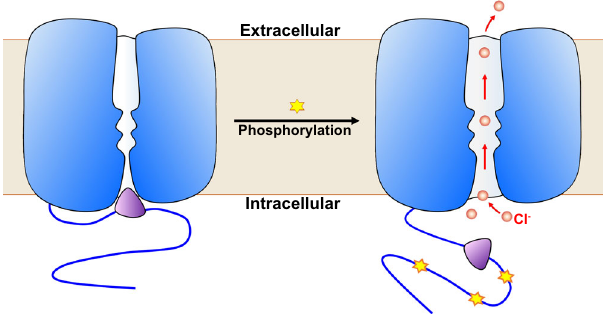
Fig. 5 Cartoon model for SLAC1 activation by phosphorylation. Phosphorylation of SLAC1 in the cytosolic domain formed by the N-terminal and C-terminal tails leads to structural rearrangements which triggers the plug region ’ s dissociation from the transmembrane domain and releases its inhibition to the pore. Release of the cytosolic plug also induces structural rearrangement in the pore-forming helices, dilating the pore to allow anion